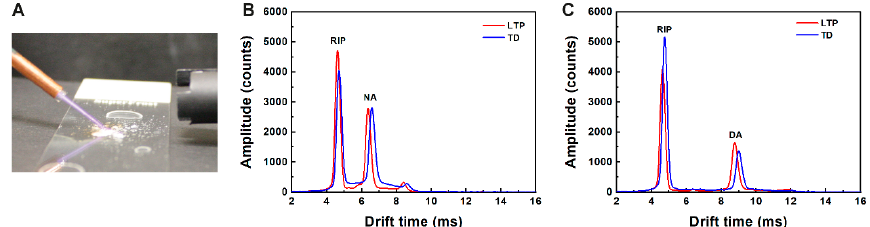
Figure 4. Experimental setup of sampling particulate contaminants from a glass surface into an IMS vapor detector using LTP ( A ) and ion mobility spectra (positive channel) of dodecylamine ( B ) and nicotinamide ( C ) sampled with LTP (red trace) compared to spectra obtained using destructive ther- mal desorption (blue trace).